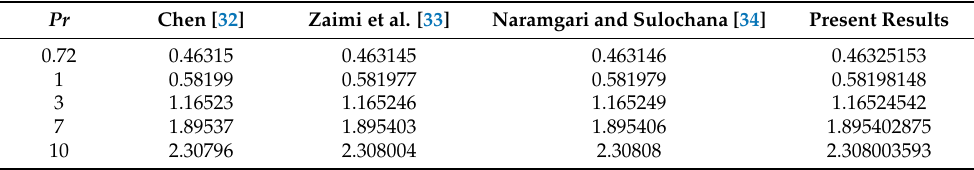
Table 4. Comparison of present results with published results for m = 0, Ec = 0, M = 0, φ 1 , φ 2 =